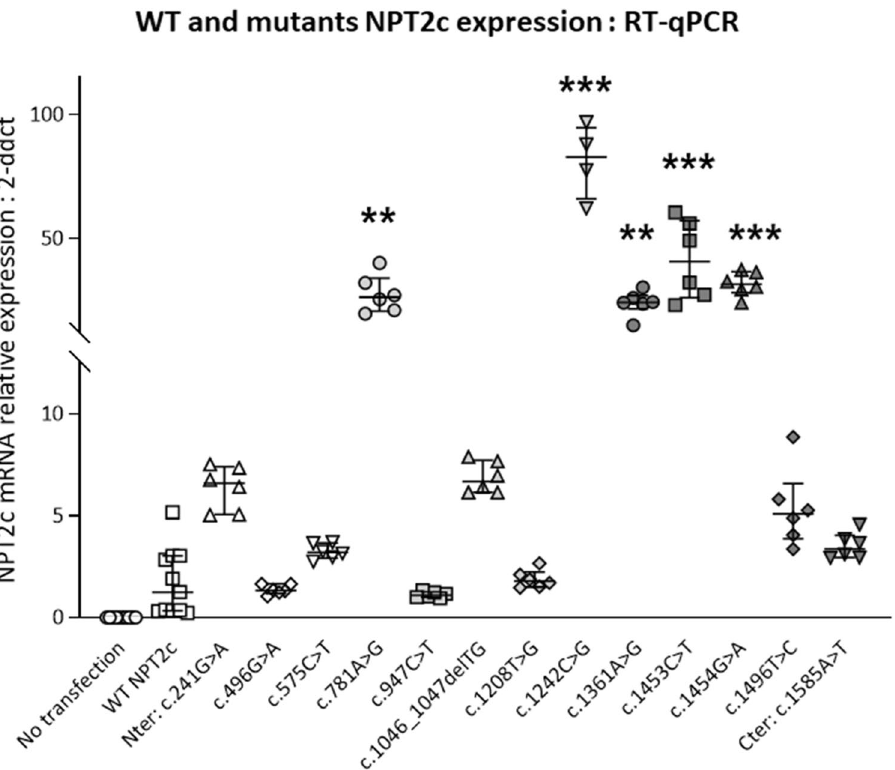
Figure 2. Comparison of the level of expression of NPT2c mRNA after transfection. HEK cells were transfected with a wild type or a mutant NPT2c or a control plasmid (0.5 μg of DNA and 1 μl of lipofectamine 2000 per well). NPT2c and GAPDH mRNA expression were quantified by RT-PCR. Quantitative data represent at least 4 independent experiments. Statistical analysis was performed using a non-parametric Kruskall–Wallis test followed by Dunn’s multiple comparison post-hoc test. *p < 0.05, **p < 0.01, ***p < 0.001, ****p < 0.0001. Simple line represents Kruskall–Wallis test and zig-zag lines represent Dunn’s multiple comparison post-hoc